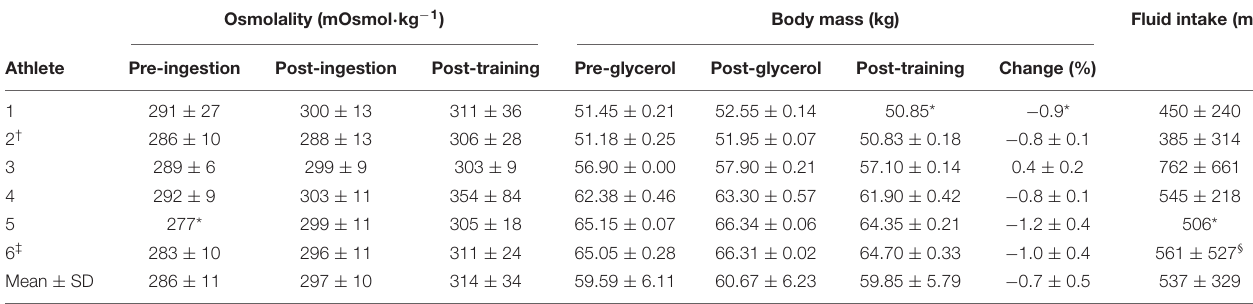
Values provided indicate mean ( ± SD) values across the two key training sessions. *Data only available from one of the two key training sessions. † Sodium only hyperhydration protocol. ‡ Athlete 6 performed an additional two training sessions. § Data only available from two of the two key training sessions. Body mass change (%) indicates the percentage difference between pre-ingestion and post-training time points.